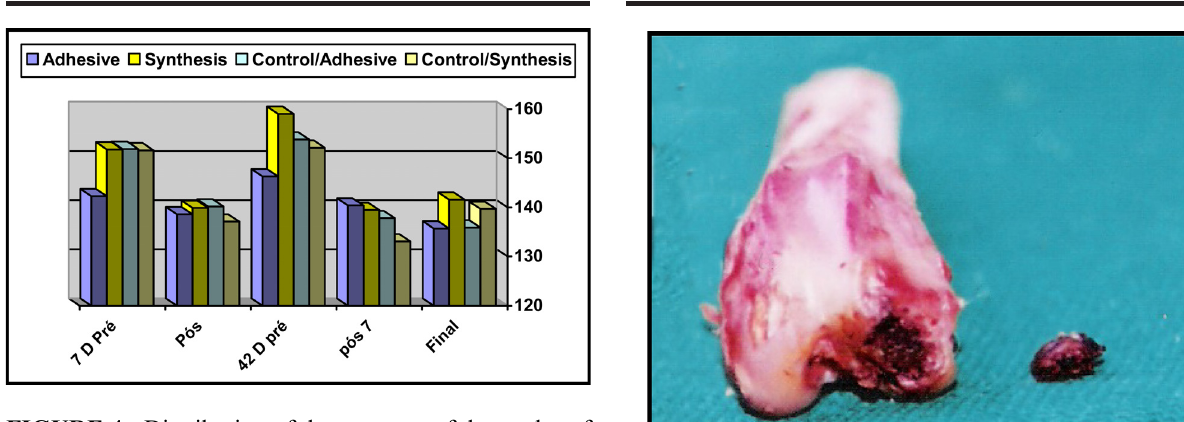
FIGURE 4 - Distribution of the averages of the angles of extension of the knees of rabbits of the Groups I (7 days) and II (42 days), measured in the x-rays in the pré and postoperative, in the different study sub-groups.